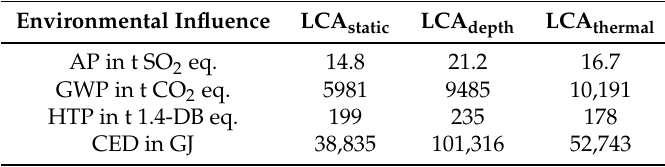
Table 6. Static and variable parts of the LCA for Perleberg with 4181 m and 241 m 3 /h. Environmental Influence LCA